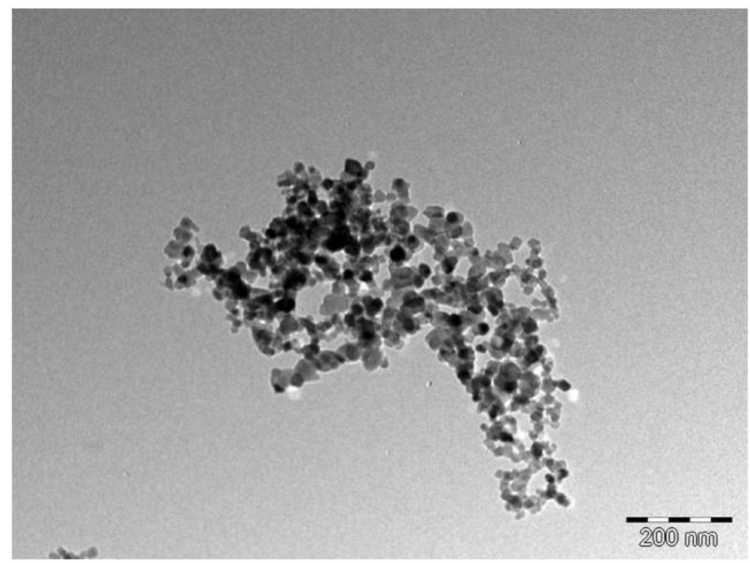
Figure 6. TEM image of TiO 2 nanoparticles.